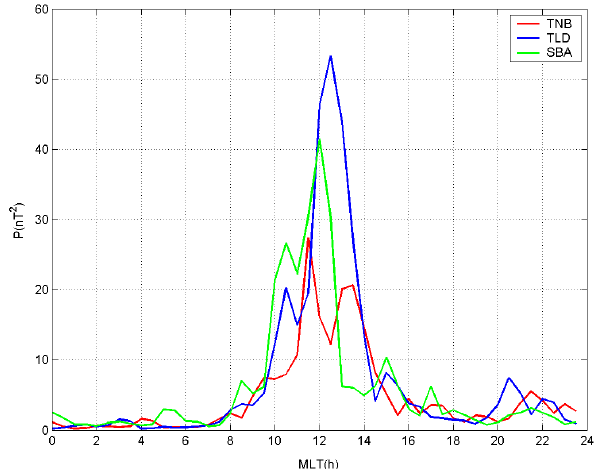
Figure 9. The MLT dependence of the pulsation power for the event on 28 February 2008, integrated in the 1–5mHz frequency band at the three